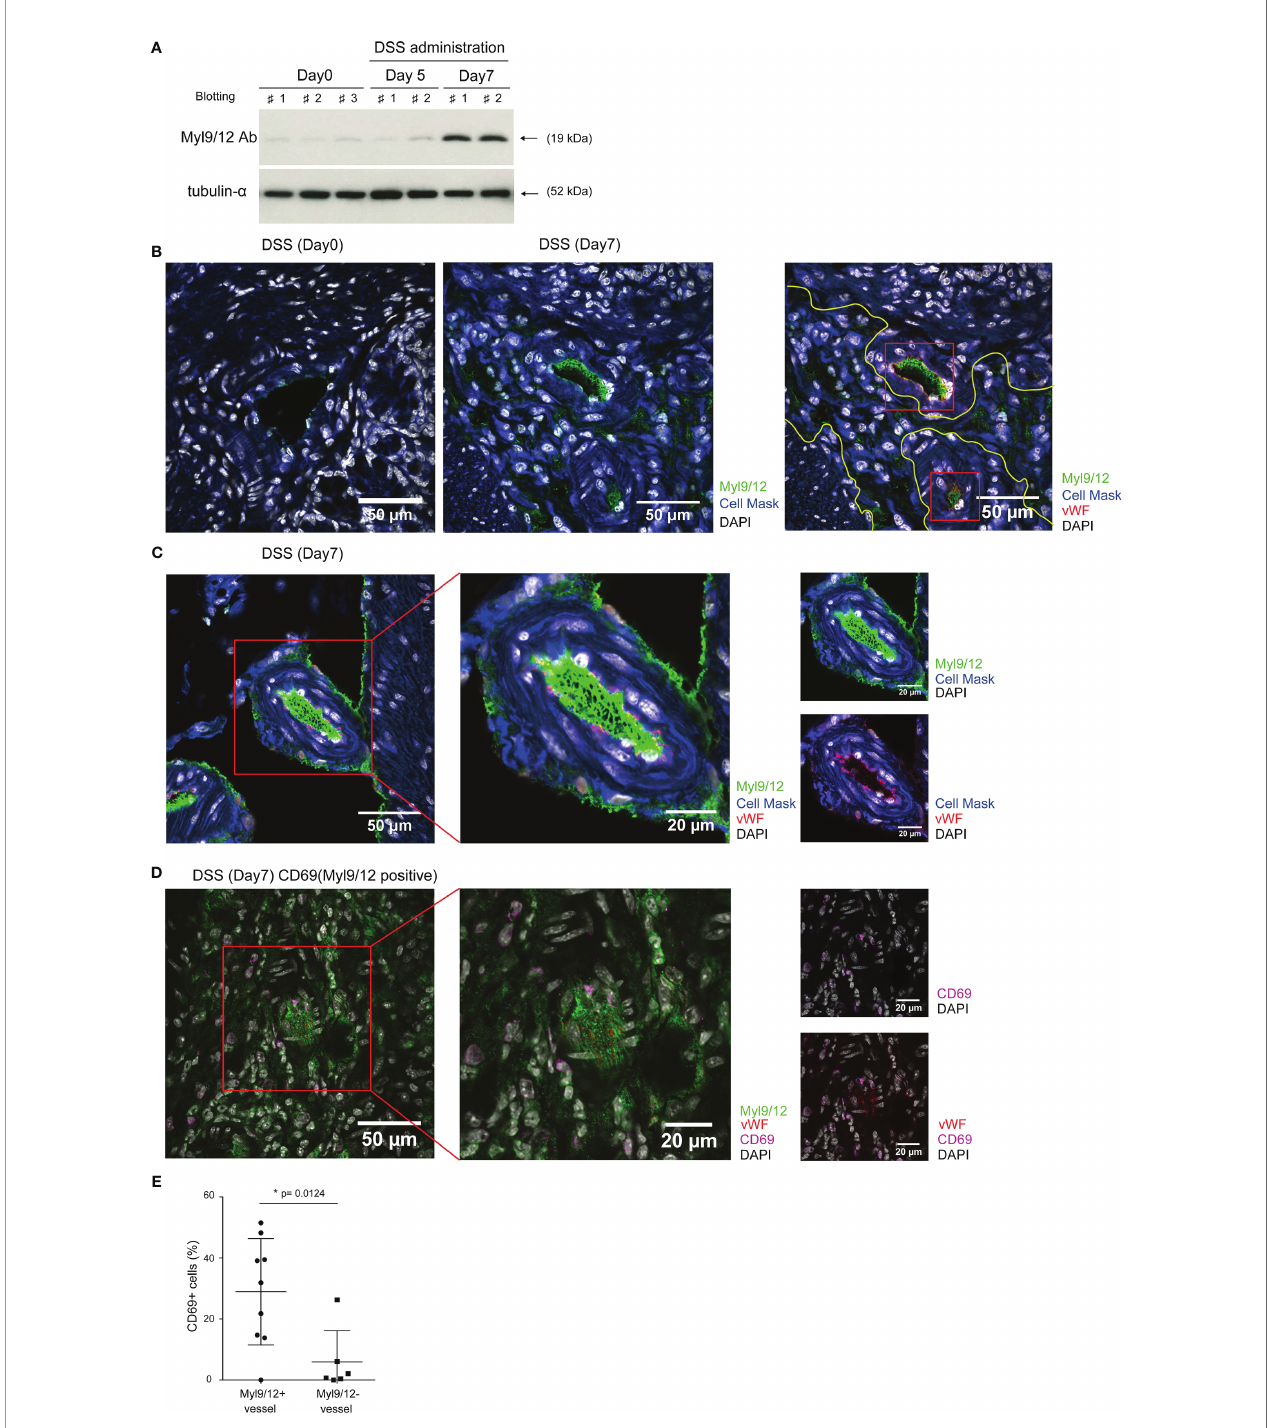
FIGURE 1 | The Myl9/12 expression in the colon after the administration of DSS. (A) Immunoblotting of the total amount of Myl9/12 protein in the colon at 0, 5, and 7 days after the administration of DSS. Tubulin- a protein was used as a loading control. (B – D) The immunohistological analysis of the colon at 0 and 7 days after the administration of DSS, stained as indicated. Red square indicates a blood vessel (C) or CD69-expressing cells close to Myl9/12-positive vessels (D) . (E) The frequency of CD69-expressing cells located near to Myl9/12-positive vessels versus Myl9/12-negative vessels in in fl amed colon specimens from mice with DSS- induced colitis. A total of nine fi elds, where Myl9/12-postive vessels were located in the center and six fi elds, where Myl9/12-negative vessels were located in the center were examined using three individual mice with DSS-induced colitis. *p <